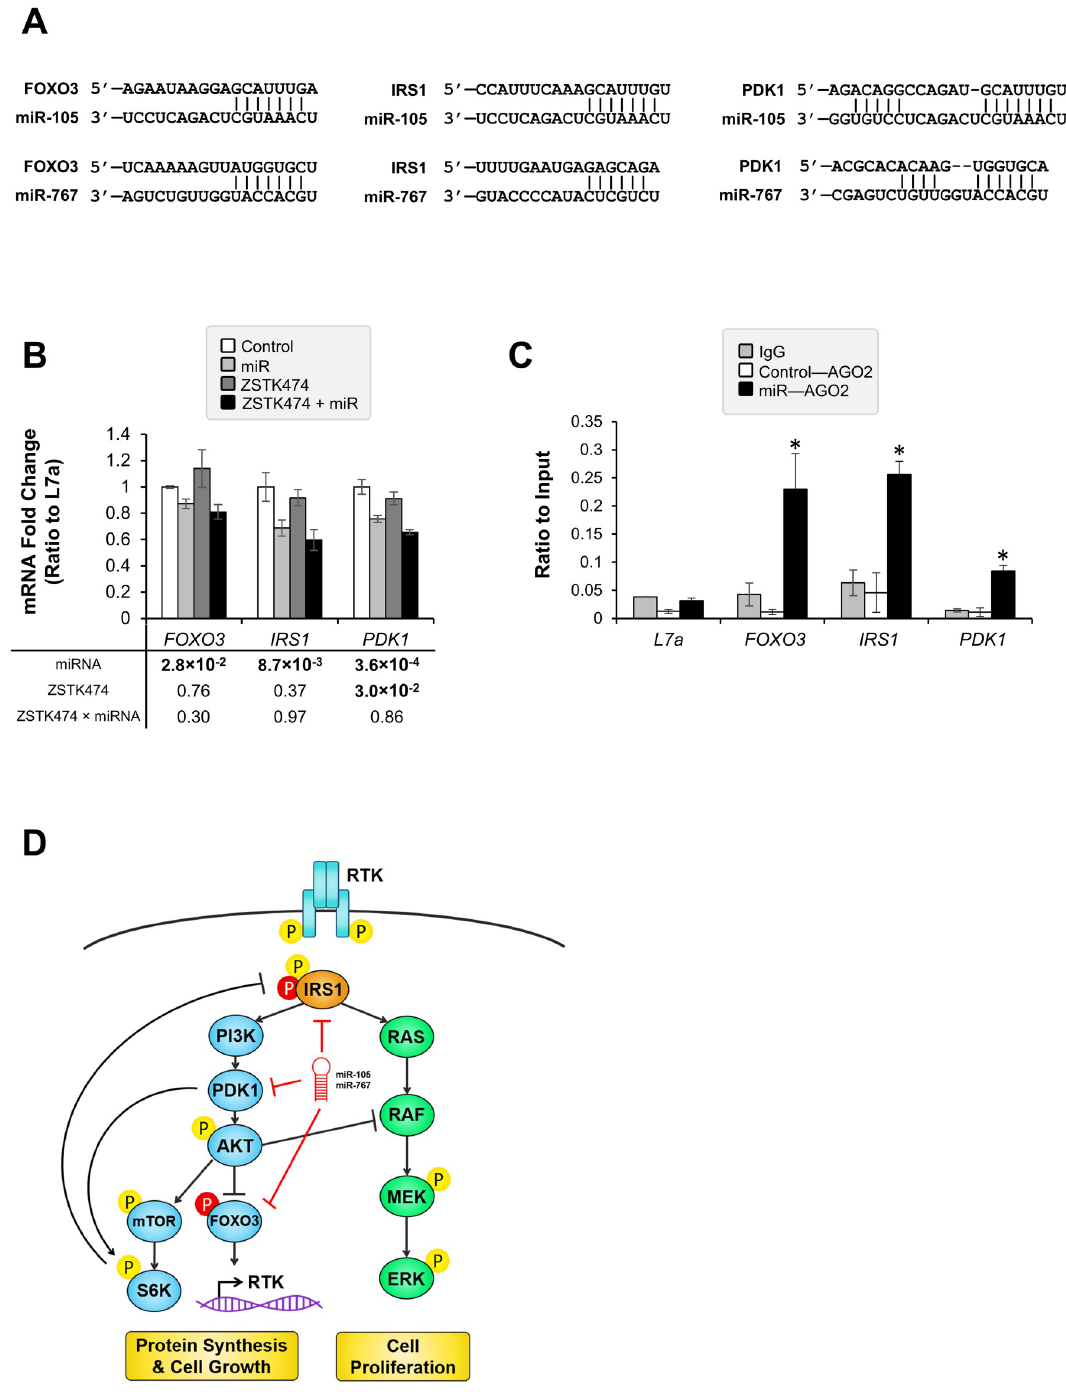
Fig 9. miR-105 and miR-767 directly target genes in the PI3K pathway that mediate crosstalk with the MAPK pathway. (A) Mature miR-105 and miR-767 sequences are predicted to bind complementary sequences in the 3’-UTRs of FOXO3 , IRS1 , and PDK1 . (B) A549 cells were treated with miR-105 and miR-767 mimics and ZSTK474. Gene expression was measured using qPCR and normalized to L7a. Each treatment condition included three replicates. ANOVA was performed. The p-values for the main effect of miRNA and ZSTK474 as well as their interaction are reported. (C) RNA immunoprecipitation measured binding between AGO2 protein and FOXO3 , IRS1 , PDK1 mRNA . Data are presented as mean ± SEM. � Denotes a significant difference between Control and miR (p < 0.05). (D) Crosstalk between the PI3K and the MAPK pathways arises from AKT inhibition of RAF, IRS1 activation of RAS, and FOXO3-mediated transcription of RTKs. miR-105 and miR-767 overexpression resulted in direct binding to IRS1, PDK1, and